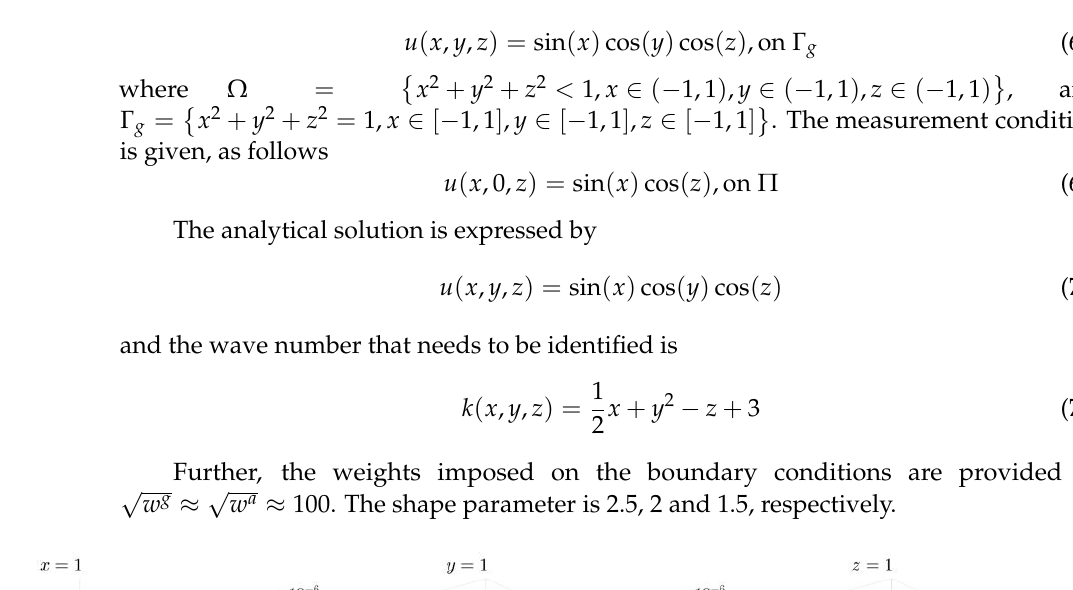
Figure 26. Condition number of stiffness matrix for the 3D parameter identification problem in cubic domain. 4.5. Three-Dimensional Inverse Helmholtz Problem of Parameter Identification in Spherical Domain We further consider another three-dimensional inverse Helmholtz problem of the parameter identification in spherical domain. The governing equation and boundary con- ditions are given as